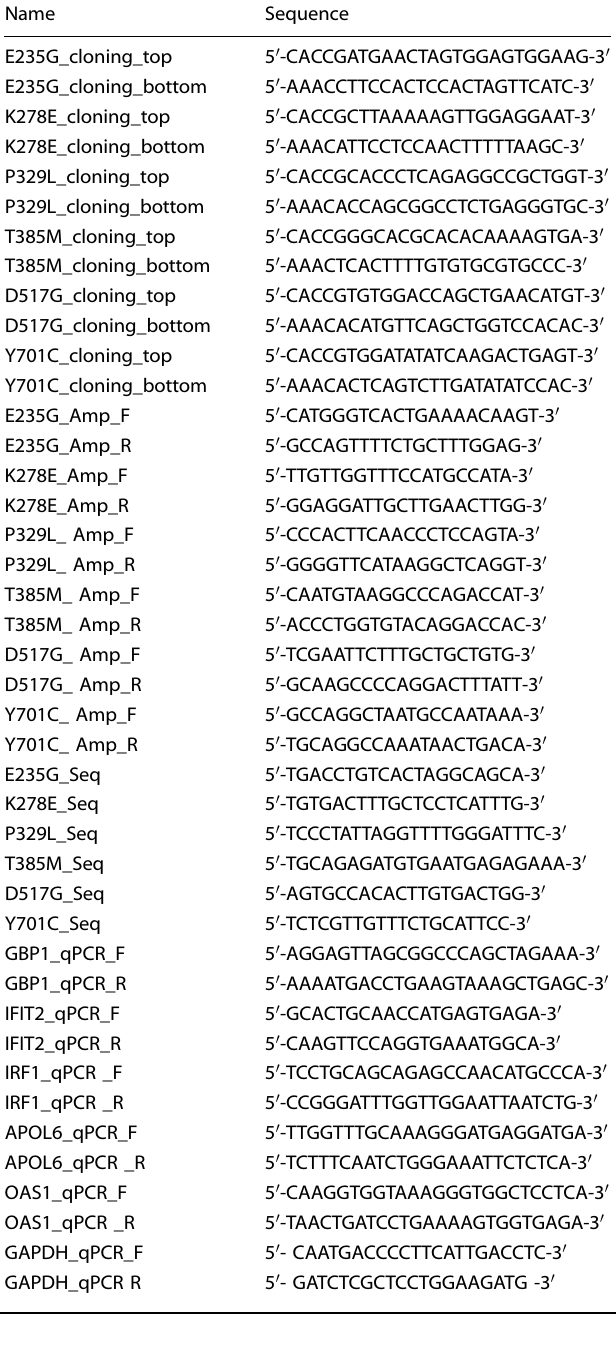
Table 4. Oligonucleotides and primers used in this